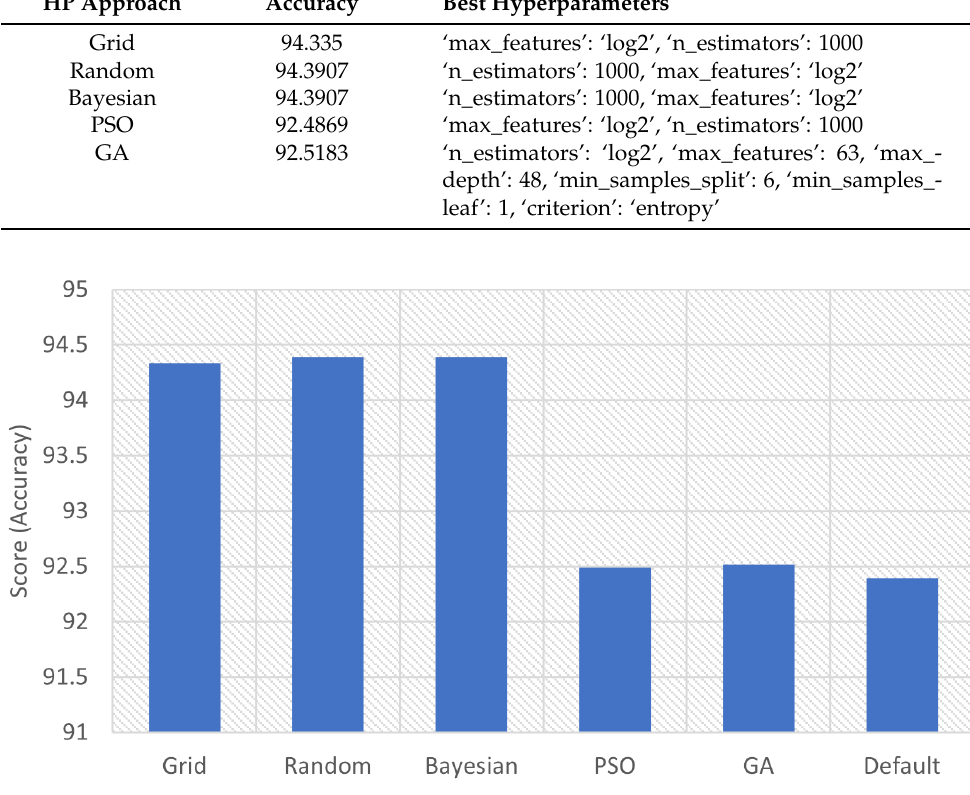
Figure 13. Hyperparameter tuning techniques versus score for Random Forest (RF).